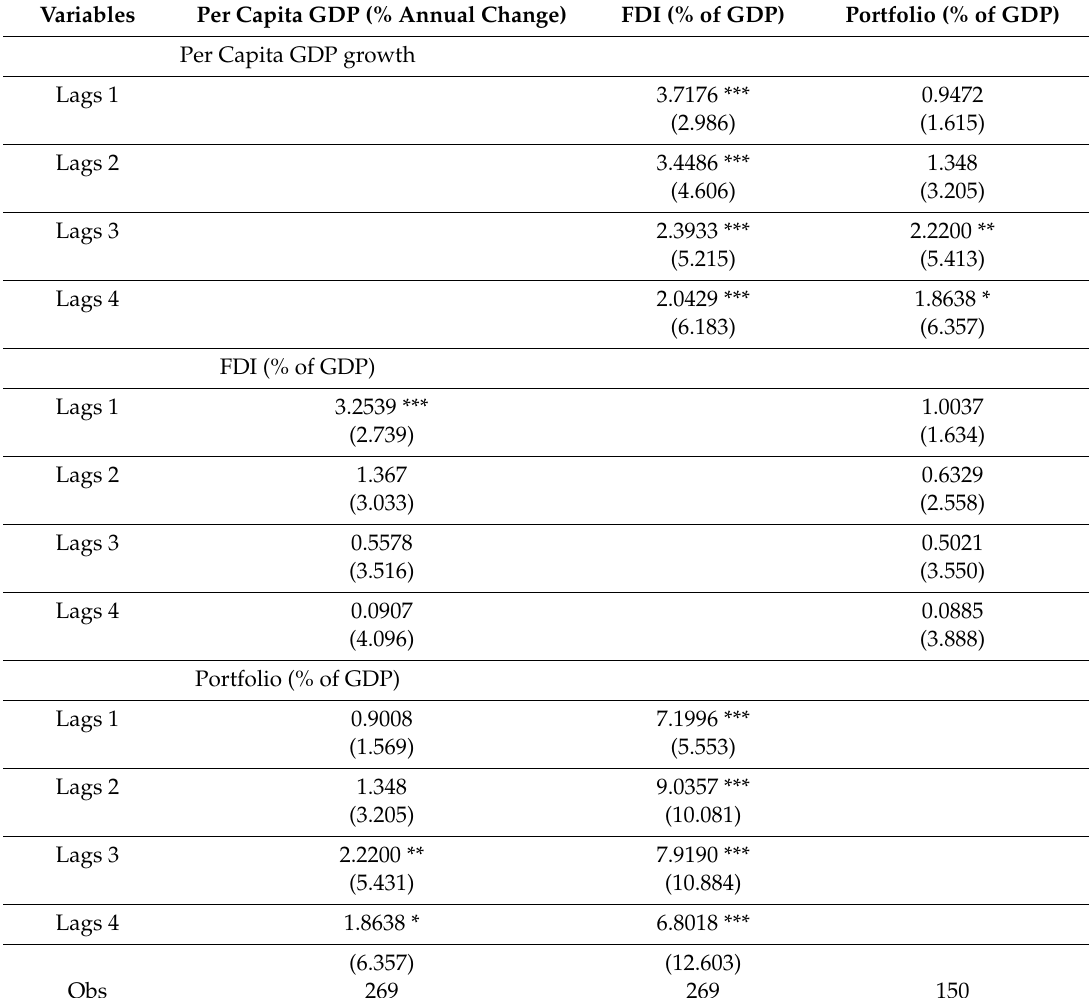
Table 3. Dumitrescu and Hurlin (2012) Granger non-causality test results. Coe ffi cient Z-bar, (.) W-bar. Variables